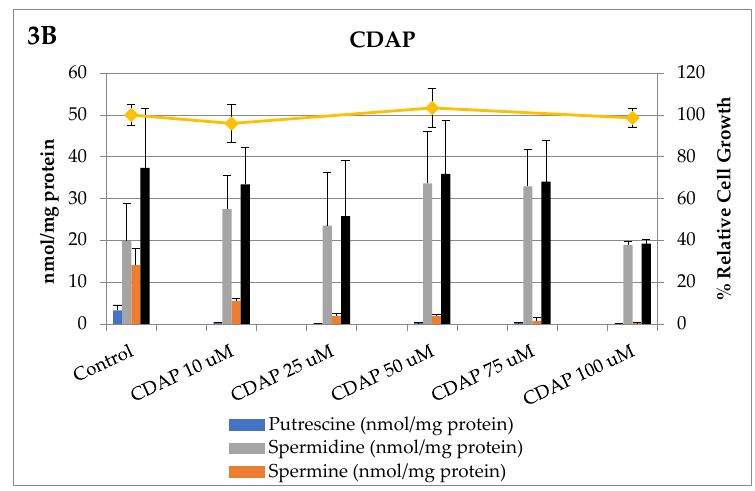
Figure 3. The effects of MCHA (Panel A) and CDAP (Panel B) on intracellular polyamine pools of L3.6pl cells after 72 h incubation. As shown in the top panel, the SRM inhibitor, MCHA, reduced intracellular spermidine pools in a dose-dependent manner and at 100 µM resulted in a 73% reduction of intracellular spermidine pools (gray bars, p < 0.05) and provided an overall 42% reduction of total intracellular polyamine pools (black bars). In the bottom panel, the SMS inhibitor, CDAP, reduced intracellular spermine pools in a dose-dependent manner and at 100 µM resulted in a 99.9% reduction in intracellular spermine levels and provided a 48% reduction of total intracellular polyamine pools. The reduction in spermine levels was statistically significant ( p < 0.05) for concentrations of CDAP greater than 10 µM compared to untreated controls. Neither intervention significantly reduced relative cell growth (vs. untreated controls), consistent with these cells having excess polyamine pools. Next, we measured how DFMO and the PTI (trimer44) modulated polyamine pools (Tables 1 and 2), and then tested how CDAP and MCHA, when tested individually in combination with DFMO or DFMO + PTI, affected intracellular polyamine levels and % relative cell growth. These 72 h